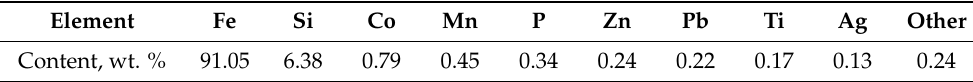
Table 1. The result of the chemical analysis of the part. Element Fe Si Co Mn P Zn Pb Ti Ag Other Content, wt. % 91.05 6.38 0.79 0.45